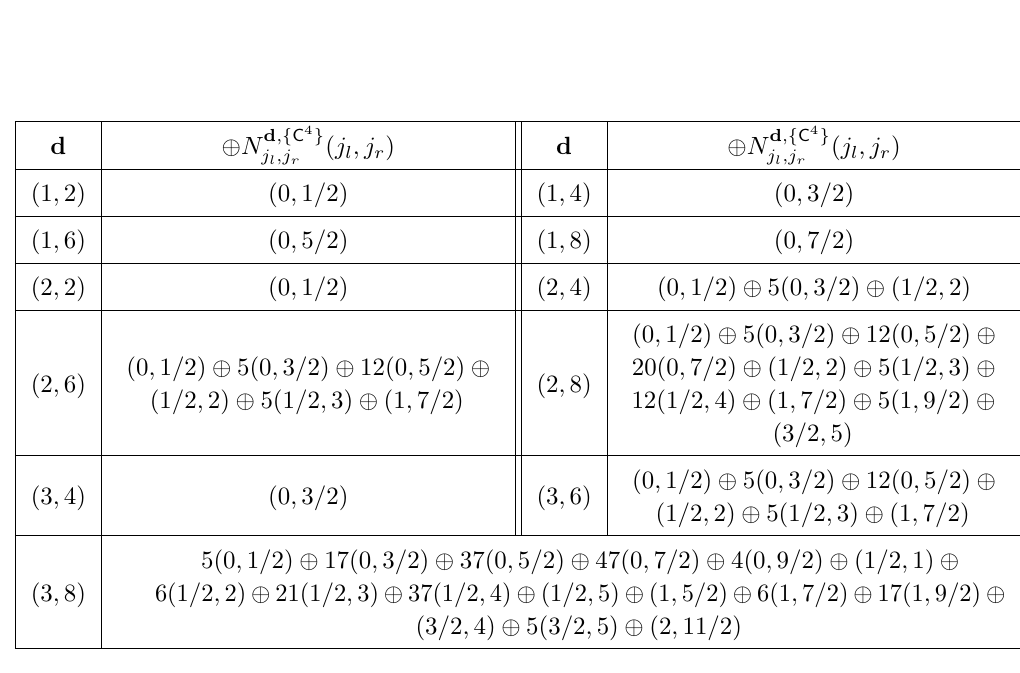
Table 7 . BPS Spectrum of the BPS sector F and d 2 ≤ 8